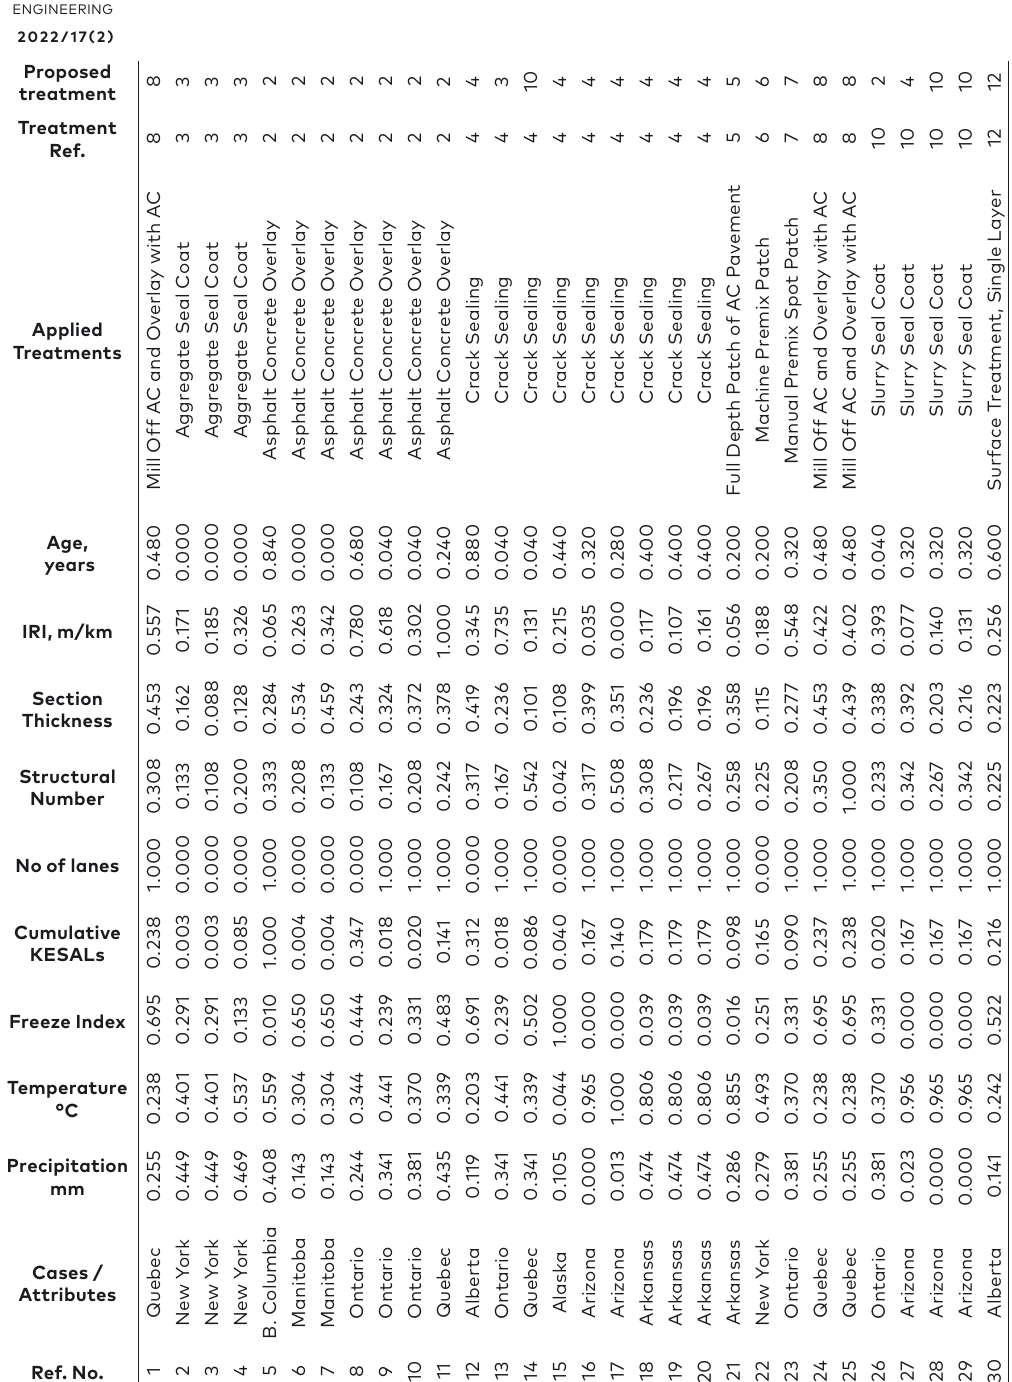
Ref.Proposed TreatmentsTreatment yearsApplied m/kmAge, ThicknessIRI, NumberSection lanesStructural KESALsNo of Cumulative °CFreeze mmTemperature AttributesPrecipitation No.Cases